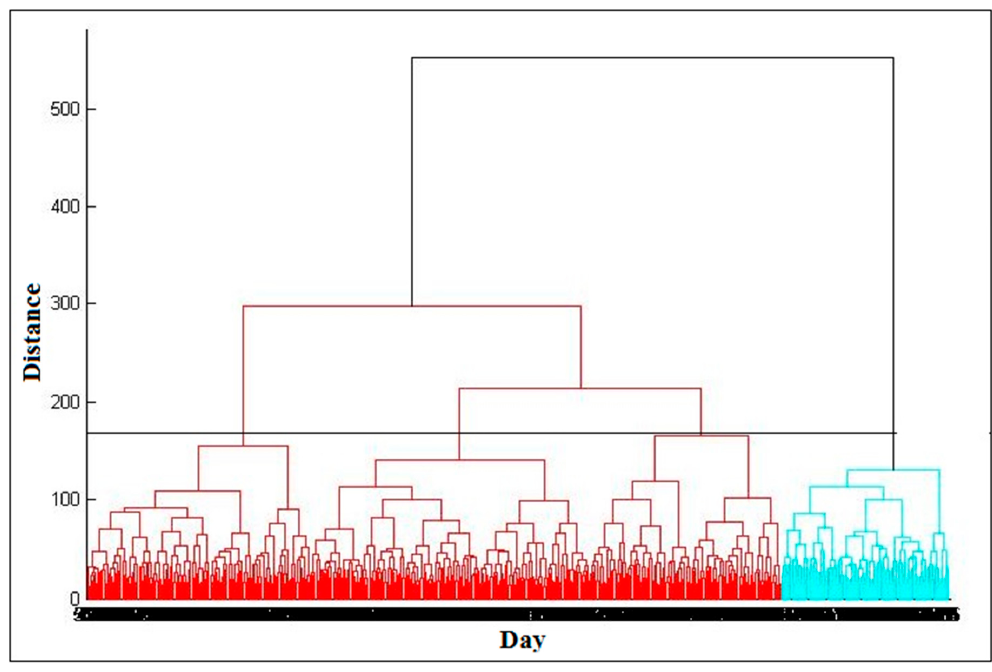
Figure 4. The dendrogram obtained as a result of conducting cluster analysis for AT during pervasive precipitation in Iran.